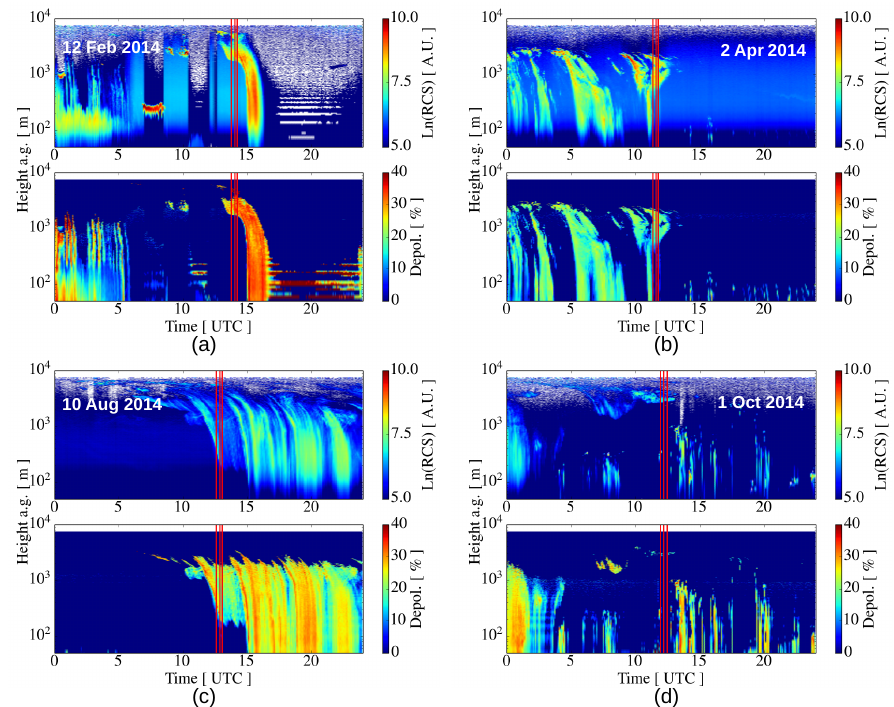
Figure 6. Colour maps of RCS and depolarisation signals performed by the lidar at Dome C for 4 selected days. The panels show the passage of an ice cloud in summer on 12 February 2014 (a) , in autumn on 2 April 2014 (b) , in winter on 10 August 2014 (c) and in spring on 1 October 2014 (d) . The red lines indicate the times at which the analysed spectra were acquired.